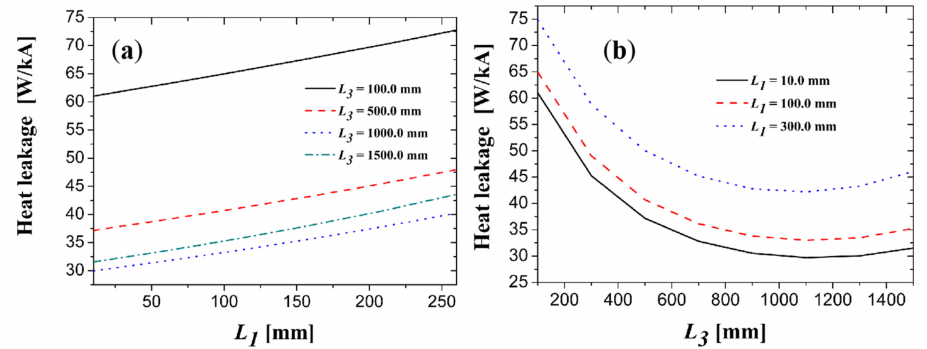
Figure A2. Iteration step 2: the coupling influence between B ( L 1 ) and C ( L 3 ) on the cold end heat leakage of PCLs (keeping parameters r 1 = 4.0 mm, r 2 = 10.0 mm, L 2 = 3.5 mm unchanged; in this iteration Q min = 29.7 W/kA). ( a ) The heat leakage vary with B ( L 1 ); ( b )The heat leakage vary with C ( L 3 ).